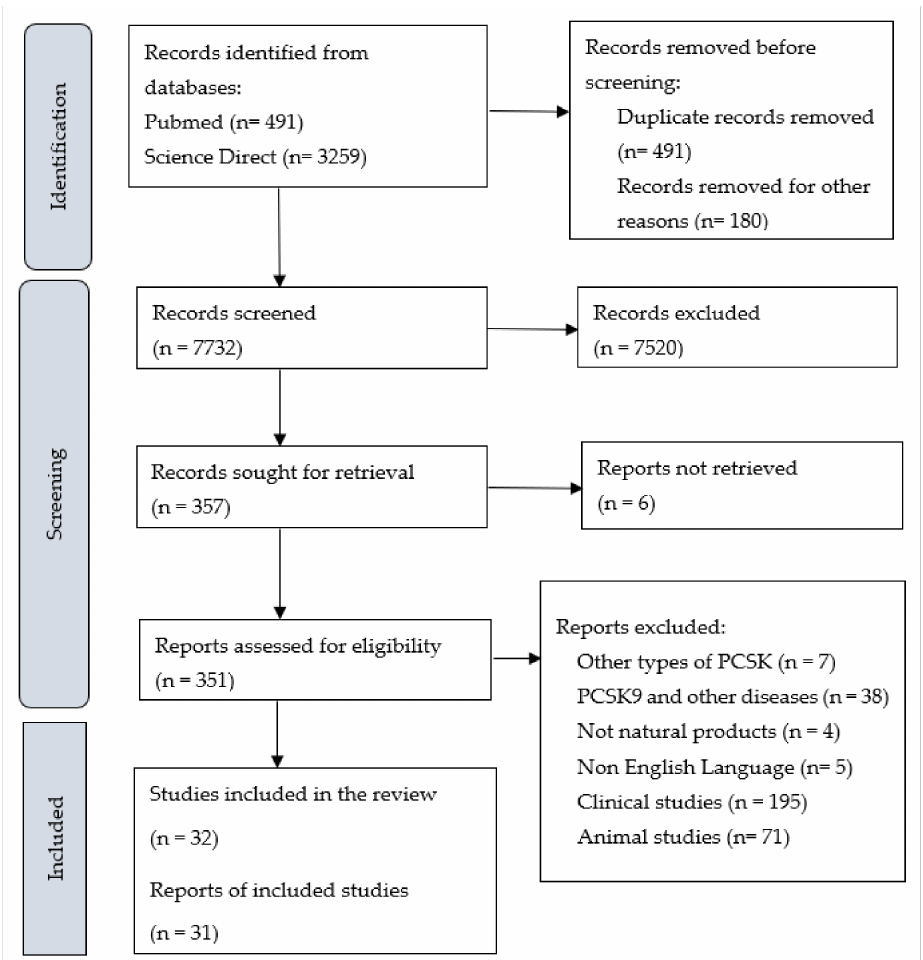
Figure 1. PRISMA Flowchart of